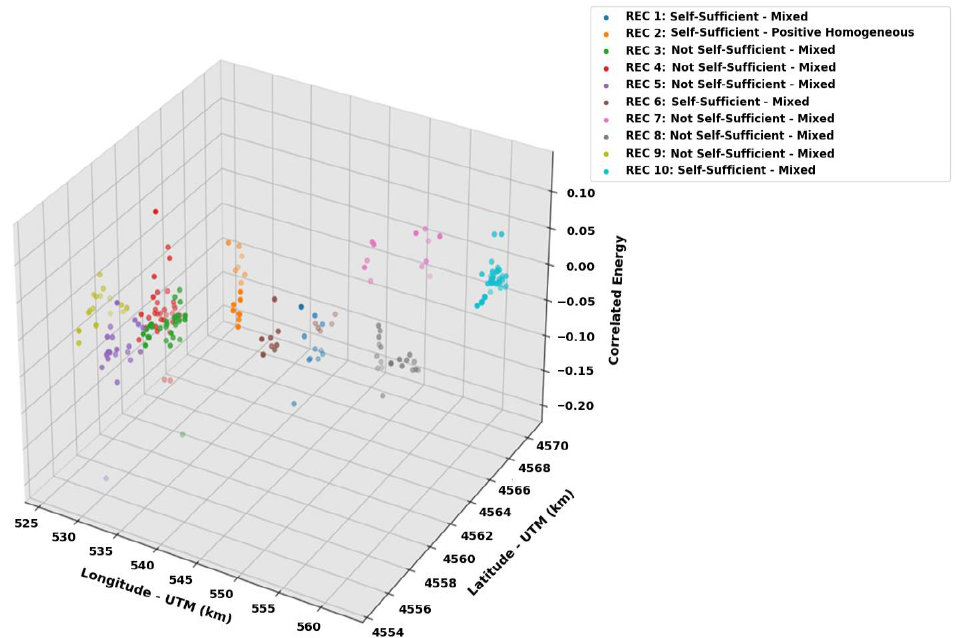
Figure 12. Members distributed by REC (with the real REC identified)—K-means.